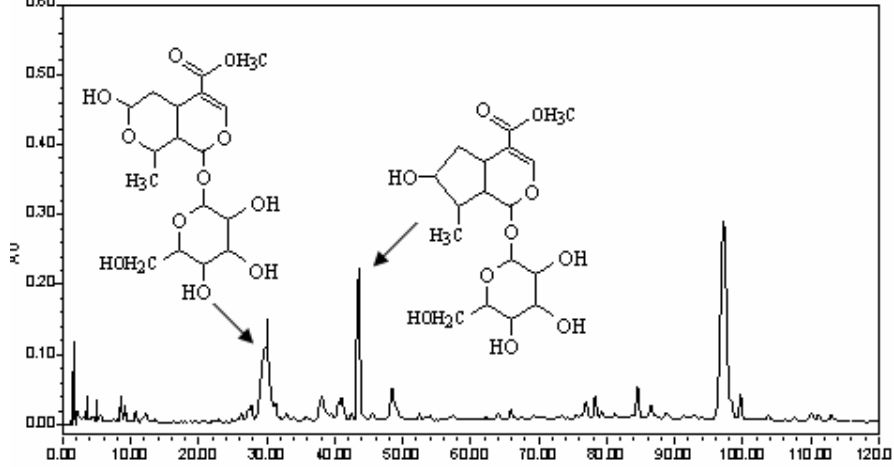
Figure 3. The HPLC charts of LW and the marked peaks of morronside and